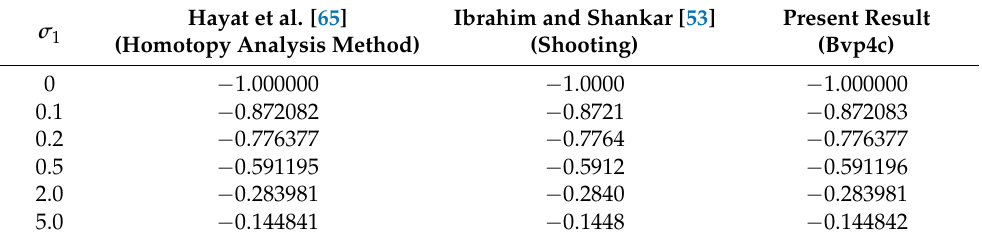
Table 3. Values of f (cid:48)(cid:48) ( 0 ) for extended sheet ( λ = 1 ) when ϕ 1 = ϕ 2 = L = B v = 0 and s = 0. Hayat et al. [65] Ibrahim and Shankar [53] σ 1